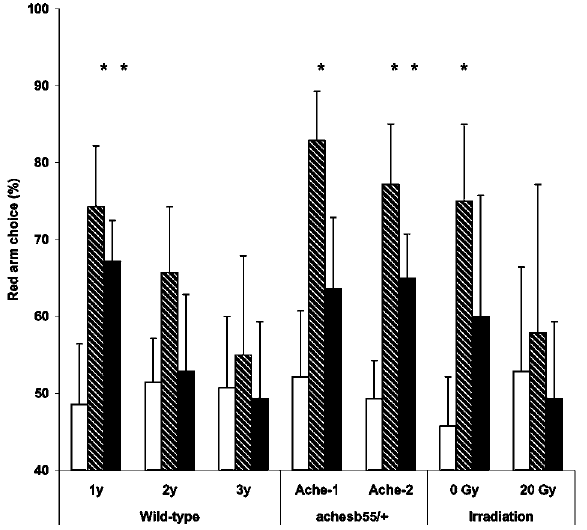
Figure 8. Generalization of red color preference in a ‘‘different condition’’ of the T-maze at Baseline, following Conditioning and Extinction phases of CPP paradigm. Y-axis: percent of red arm choices over 14 consecutive trials. X-axis – zebrafish age/strain. White bar – Baseline; diagonal pattern – after Conditioning, black – after Extinction. * p , 0.05 relative to each group Baseline.